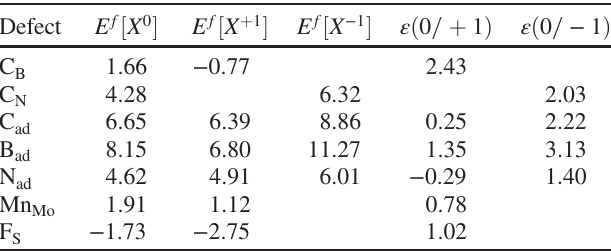
TABLE II. Formation energies and charge transition levels for all considered defects in 2D h -BN and MoS 2 (in eV). For formation energies of charged defects, the Fermi level is set to the valence band maximum. Charge transition levels are referenced to the valence band maximum. Substitutional defect formation energies are taken from the extrapolation, whereas adatom energies are taken from the special vacuum calculation with a 6 × 6 supercell.